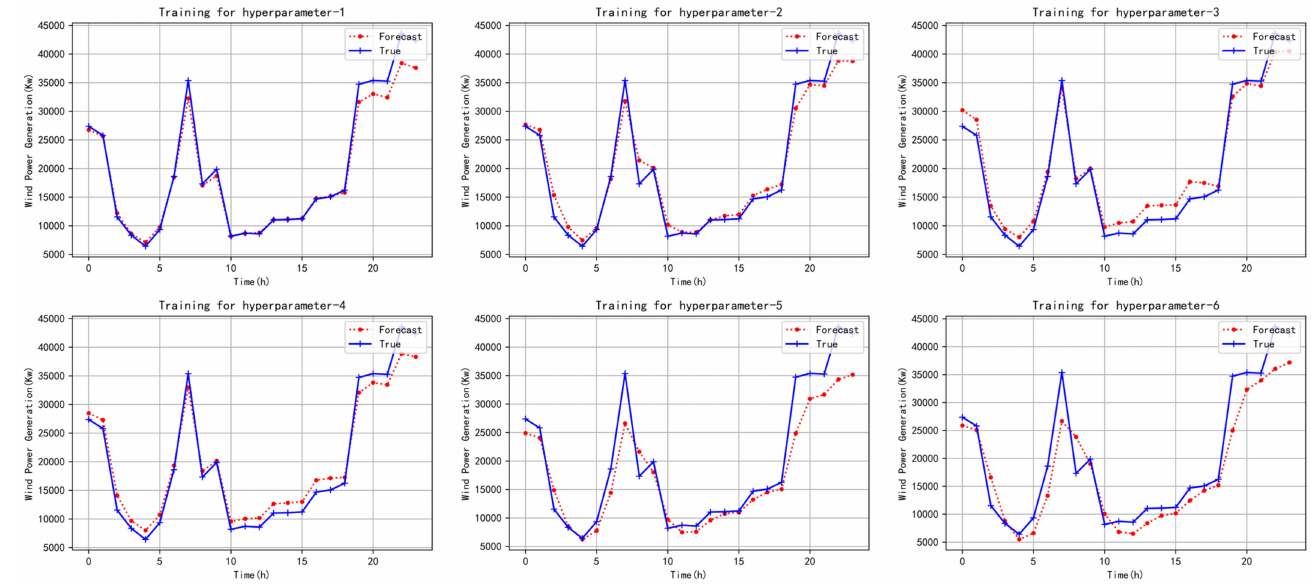
Figure 4. Training for different